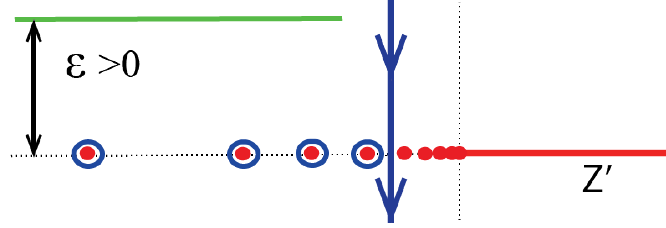
Figure 4. The contour of Figure 3 is deformed analytically such that it encircles the low-lying bound-state poles of g x and the other part is taken along an imaginary direction. 1